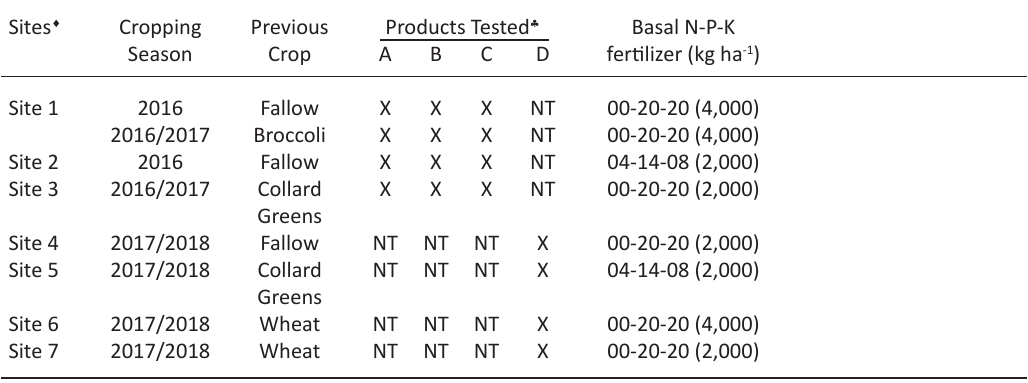
Table 2. Cropping seasons, previous crops, products tested, and basal fertilization at each experimental site Sites